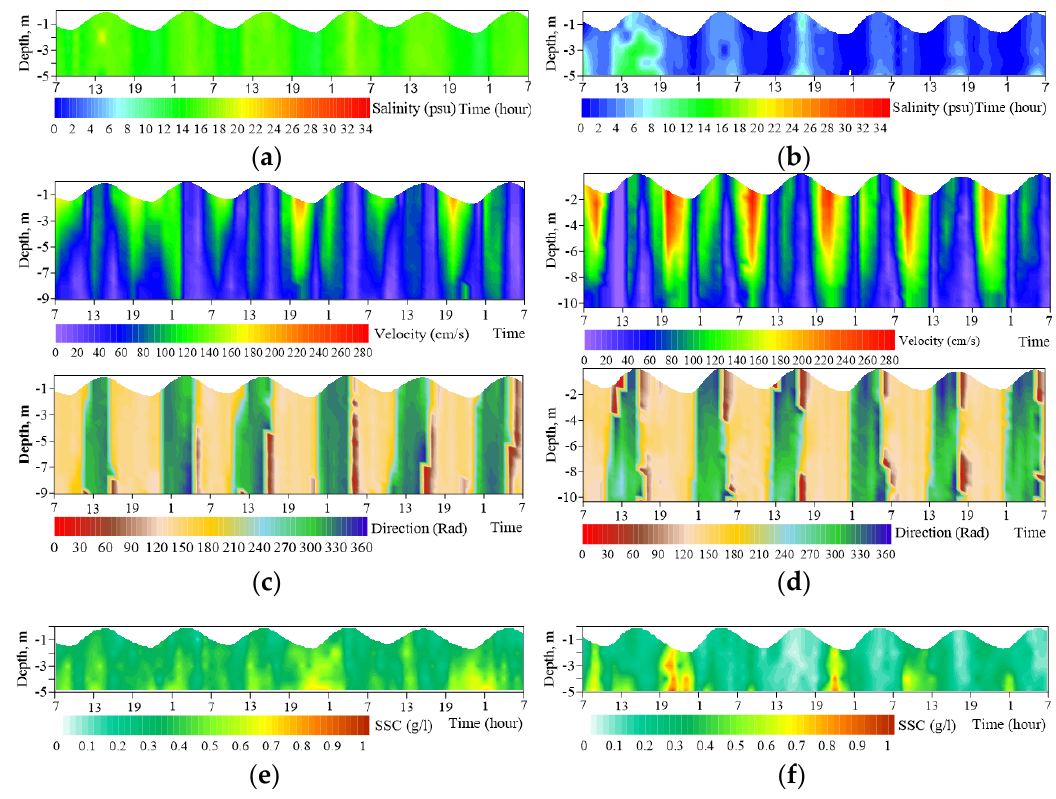
Figure 6. Time series plot of the distribution of salinity, currents (velocity, direction), and SSC at Station S11 in the dry season (9–12 April 2009) and the flood season (22–25 August 2009): ( a ) salinity in the dry season; ( b ) salinity in the flood season; ( c ) current in the dry season; ( d ) current in the flood season; ( e ) SSC in the dry season; ( f ) SSC in the flood season.